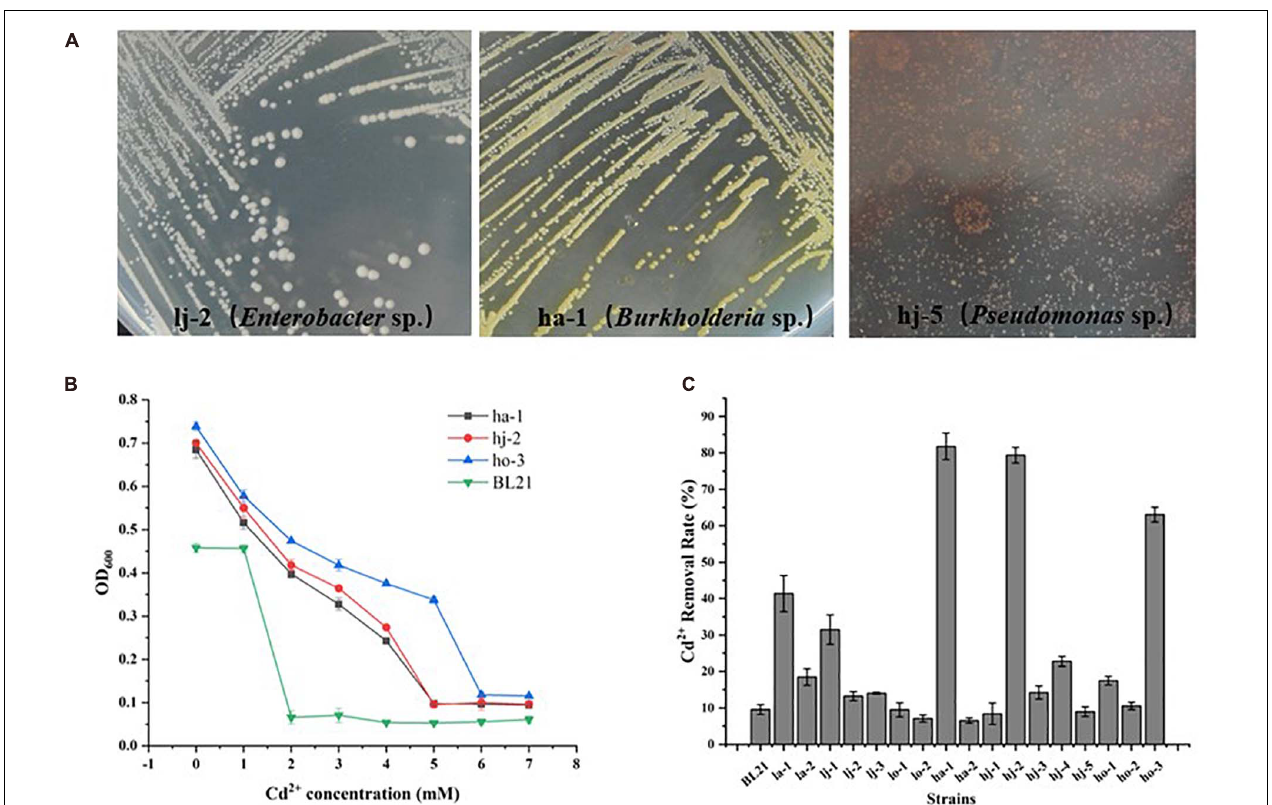
FIGURE 4 | Colony morphology of Cd-resistant bacteria and evaluation of their minimum inhibitory concentration of Cd 2 + (Cd-MIC) and Cd 2 + removal rate. (A) Colony morphology of partial Cd-resistant strains. (B) Determination of Cd-MIC for Cd-resistant bacteria in varied at different concentrations of Cd. (C) Evaluation of Cd 2 + removal rate for Cd-resistant bacteria, which was measured in LB liquid medium supplementation with 0.1 mM CdCl 2 and shaken at 200 rpm at 37 ◦ C for 24